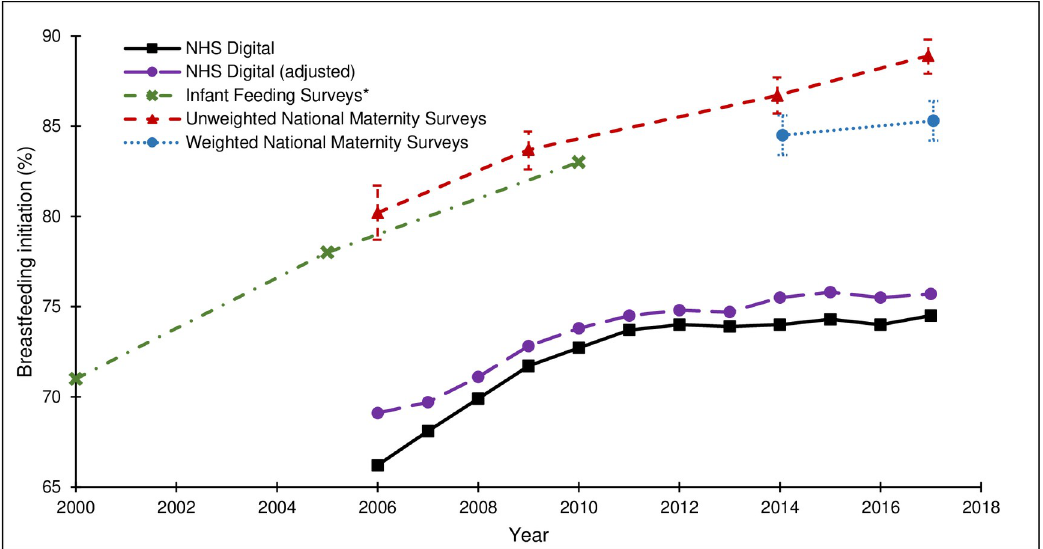
Fig 5. Breastfeeding initiation rates from the national maternity surveys^, IFS and NHS Digital. ^ Women gave birth in 2009, survey conducted in 2010; Women gave birth in 2017, survey conducted in 2018. � IFS data for 2005 and 2010 refers to England only; data for 2000 combines England and